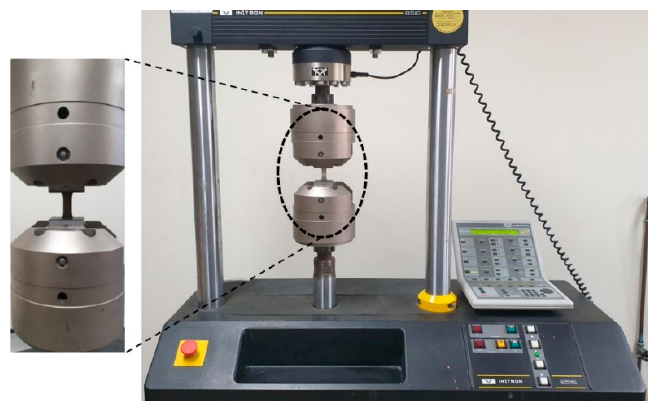
Figure 4. Test setup for fatigue tests.